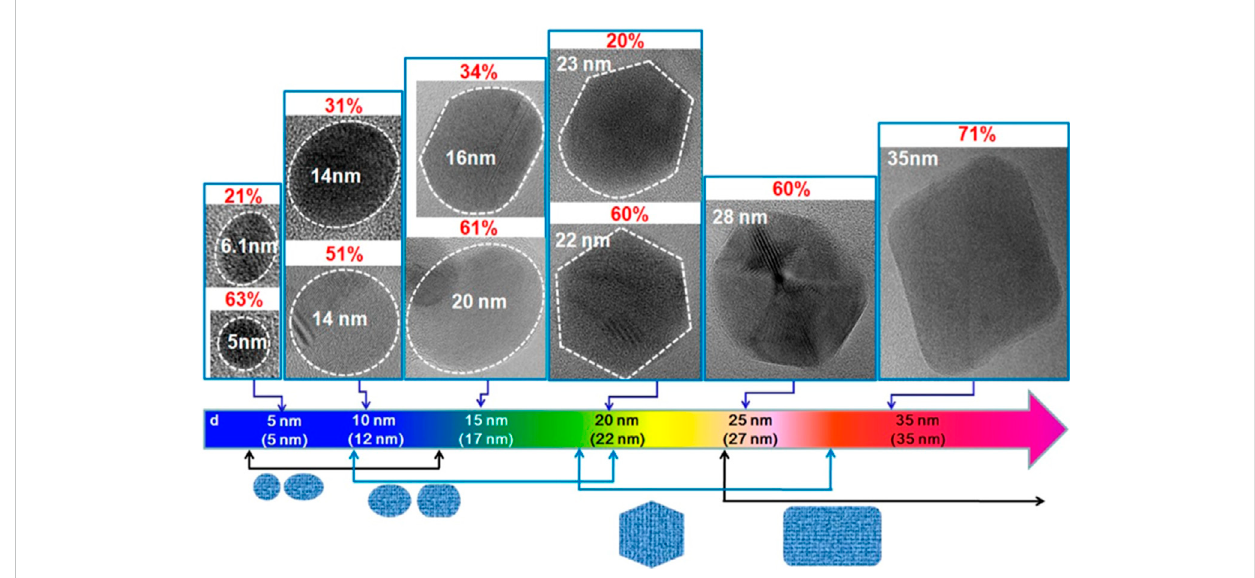
FIGURE 4 HRTEMimagesofQDs presented their primary shapesand correspondingpopulations (p)astheaverage size oftheQDs increases (Kimetal.,2012).